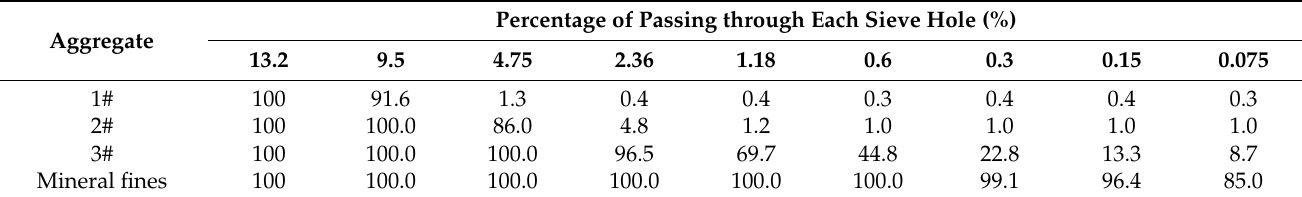
Table 9. Screening results of various aggregates and powders.